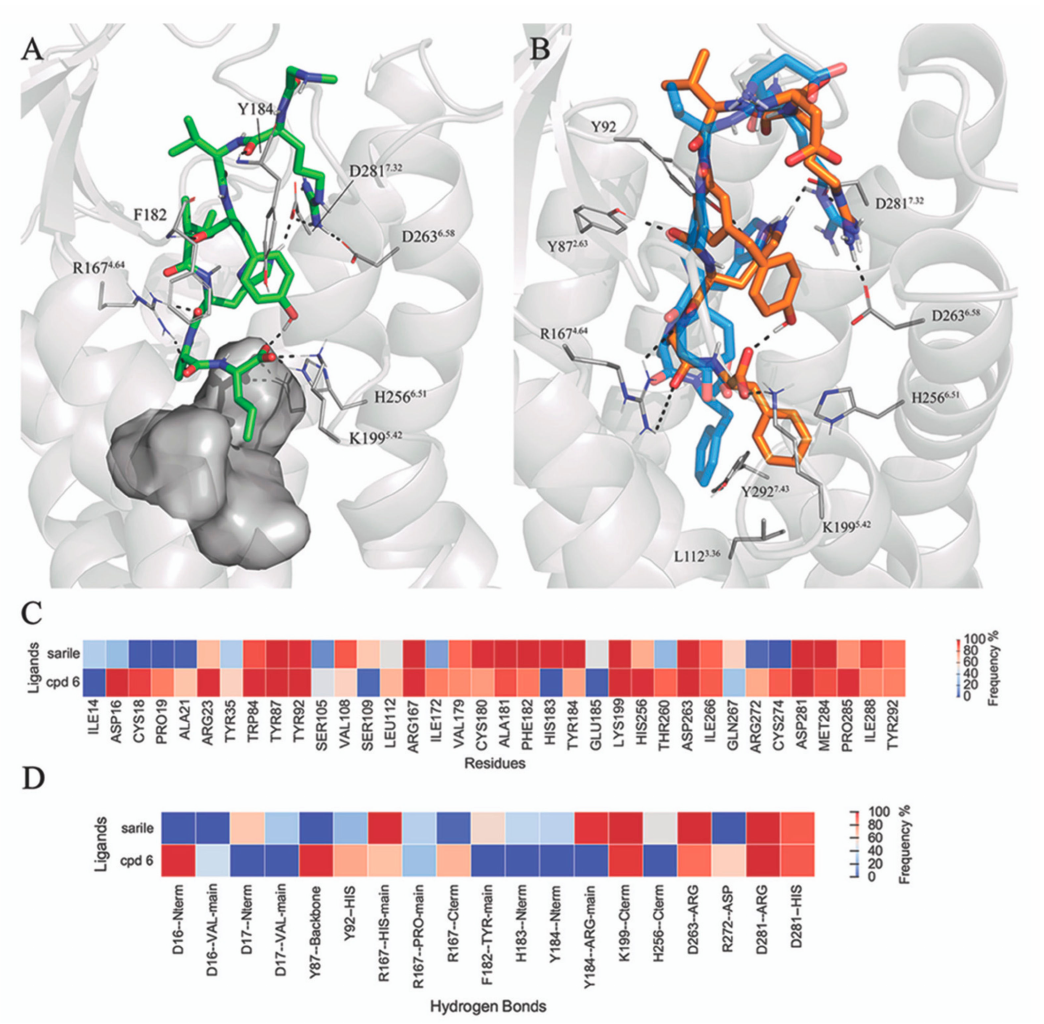
Figure 4. ( A ) Binding pocket of sarile ( 1 ) in AT1R. ( B ) Binding mode of 6 (orange sticks) in AT1R (gray ribbons), with the binding mode in AT2R overlaid in the background in blue. The heat-maps represent atom contacts ( C ) and hydrogen bonds ( D ) occurring more than 30% of the simulation time between 1 , 6 and